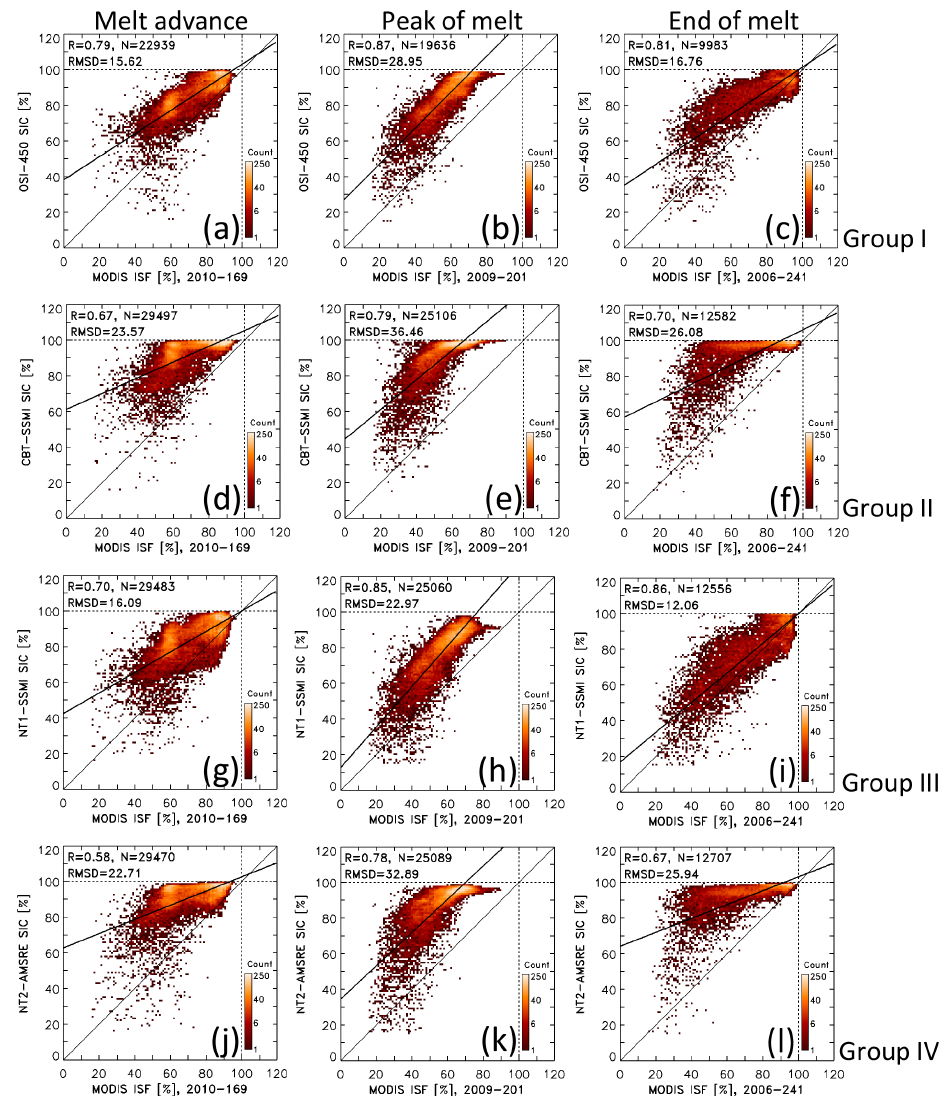
Figure 8. Two-dimensional histograms of the distribution of PMW SIC ( y axis) versus MODIS ISF ( x axis) data pairs using a bin size of 1% for the same 8d periods as shown in Fig. 7e–p, i.e. melt advance, peak melt, and end of melt. Panels (a–c) show OSI-450 (for group I), (d–f) CBT-SSMI (for group II), (g–i) NT1-SSMI (for group III), and (j–l) NT2-AMSR-E (group IV). The thin black line is the identity line. The thick black line denotes the linear regression through the data pairs. At the top left of every image we display the linear correlation coefficient R , the number of data pairs N , and the root-mean-squared difference (RMSD); the latter is given in percent. The leftmost, middle, and rightmost columns represent melt advance, peak of melt, and end of the melt, respectively. Respective scatter plots for pre-melt are shown in Fig. S9 in the